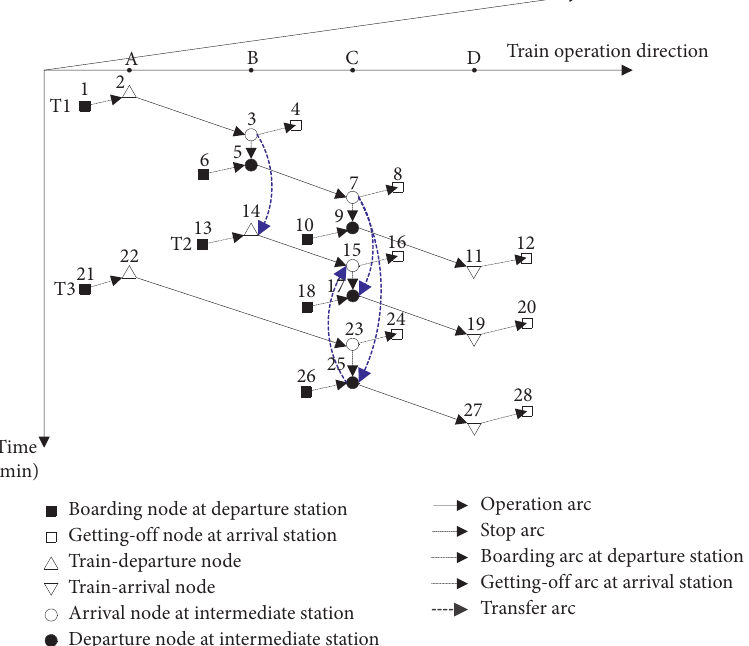
Figure 3: Three-dimensional time-space service